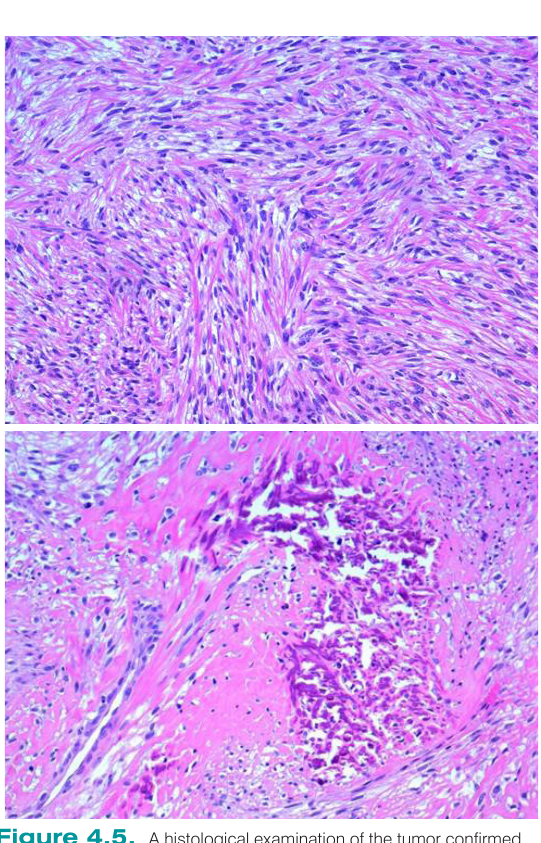
Figure 4,5. A histological examination of the tumor confirmed the diagnosis of